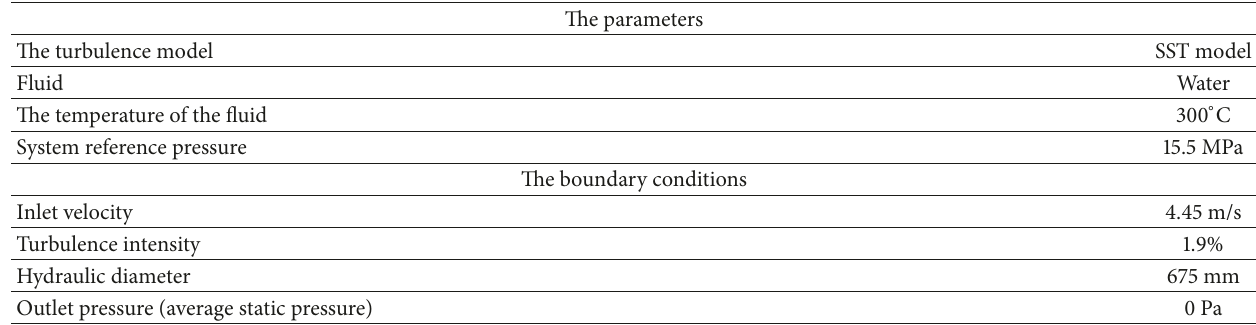
Table 1: The parameters and boundary conditions of the simulation model.